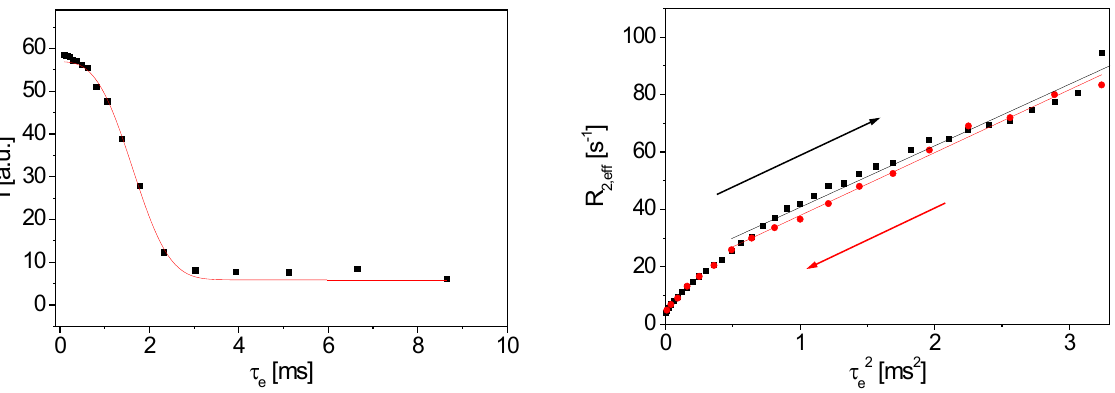
Figure 8. ( Left ): Measurements on the reference sample. Hahn-echo decay was used to determine the static gradient near the maximum sensitivity of the bent figure-8 coil ( G = 1.14 T/m). Modelling of the magnetization decays includes an offset. ( Right ): A deviation from the expected linear behavior of R 2,eff ( τ e 2 ) is found for a small τ e due to sample heating. At large τ e and a reduced sample filling level (red dots), RF heating is less significant, and the range of linearity is larger.